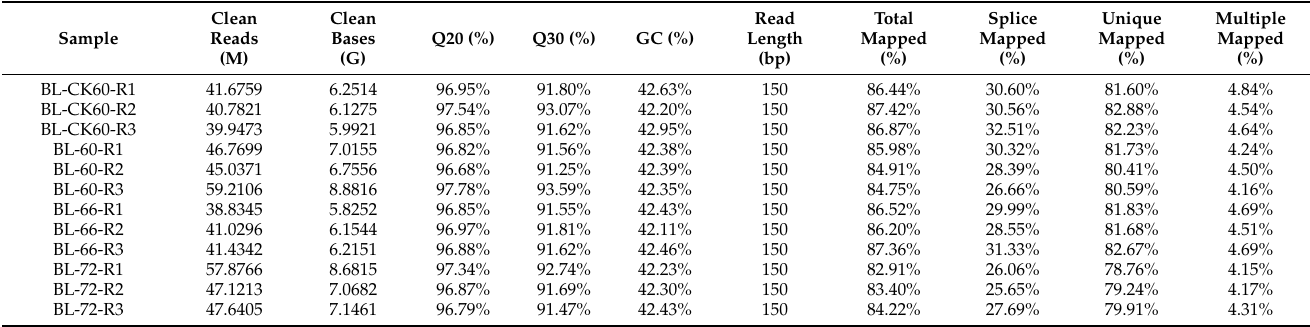
Table 1. Statistical summary of RNA-sequencing